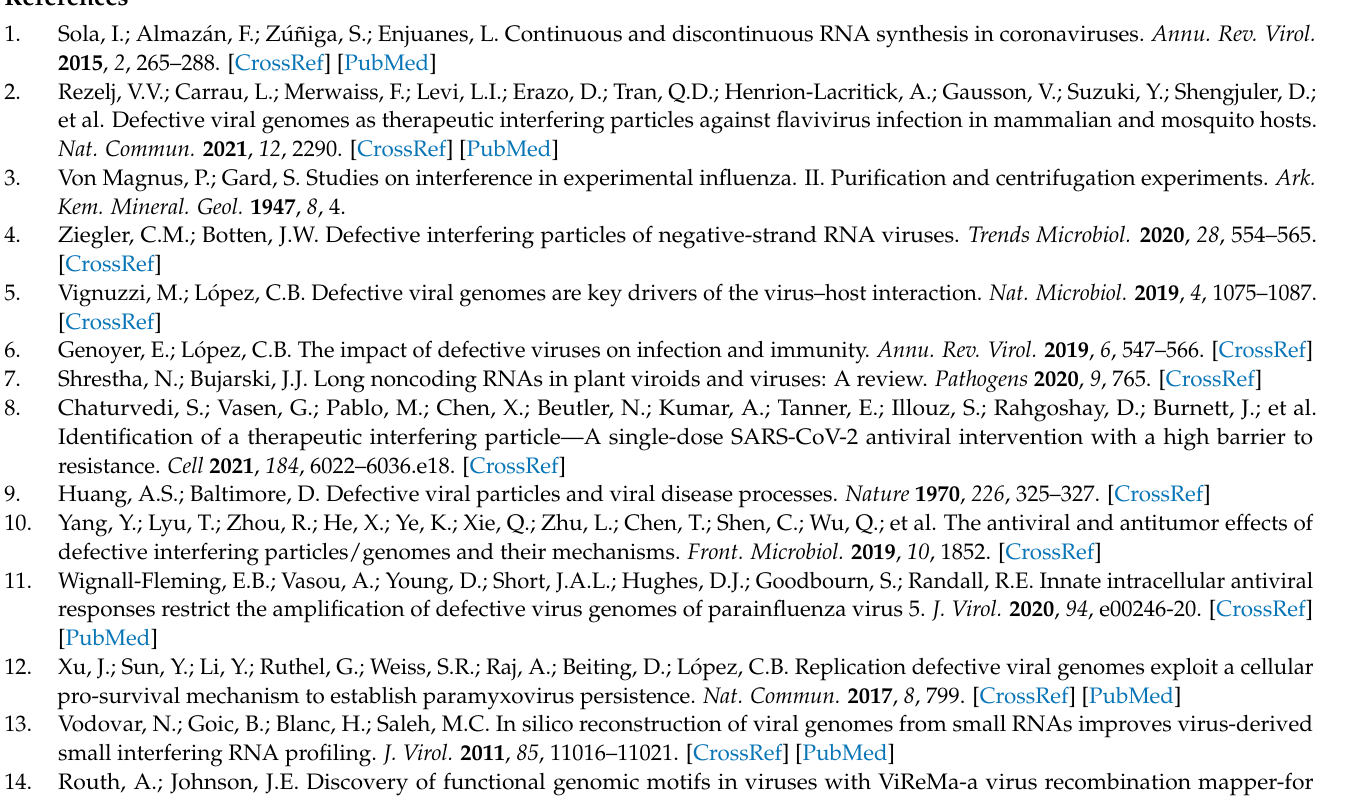
Table S1: List of random DVGs generated for each synthetic